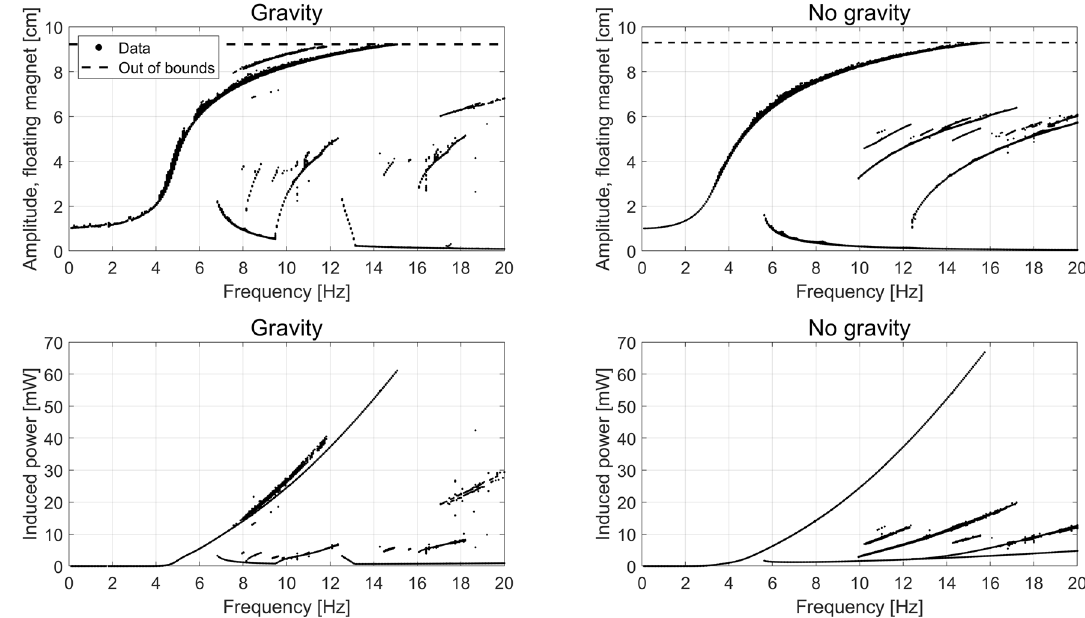
Figure 7. The amplitude and the induced power for 32 x 32 different initial conditions in position and velocity, as described in the text, with and without gravity. Only data for systems that reached steady state is shown.